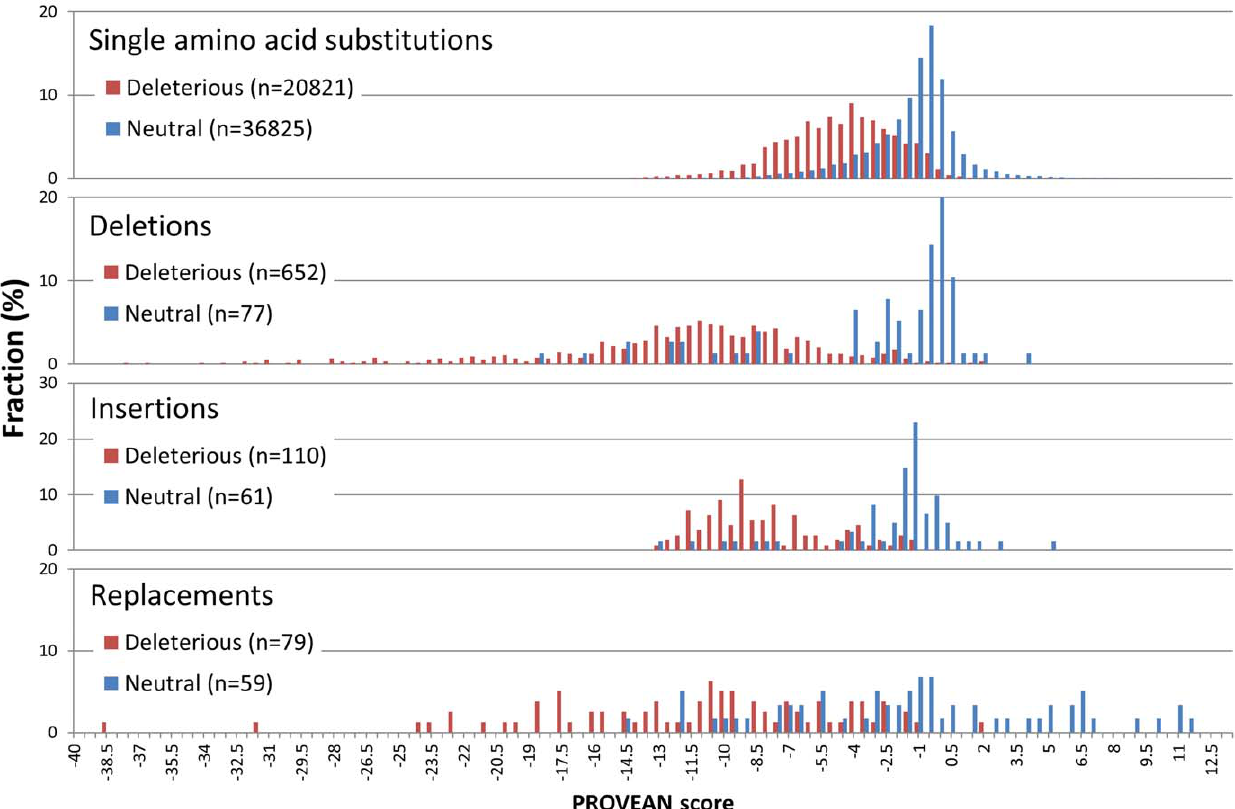
Figure 3. PROVEAN score distribution for deleterious and neutral human protein variations. For all classes of variations including substitutions, indels, and replacements, the distribution shows a distinct separation between the deleterious and neutral variations.